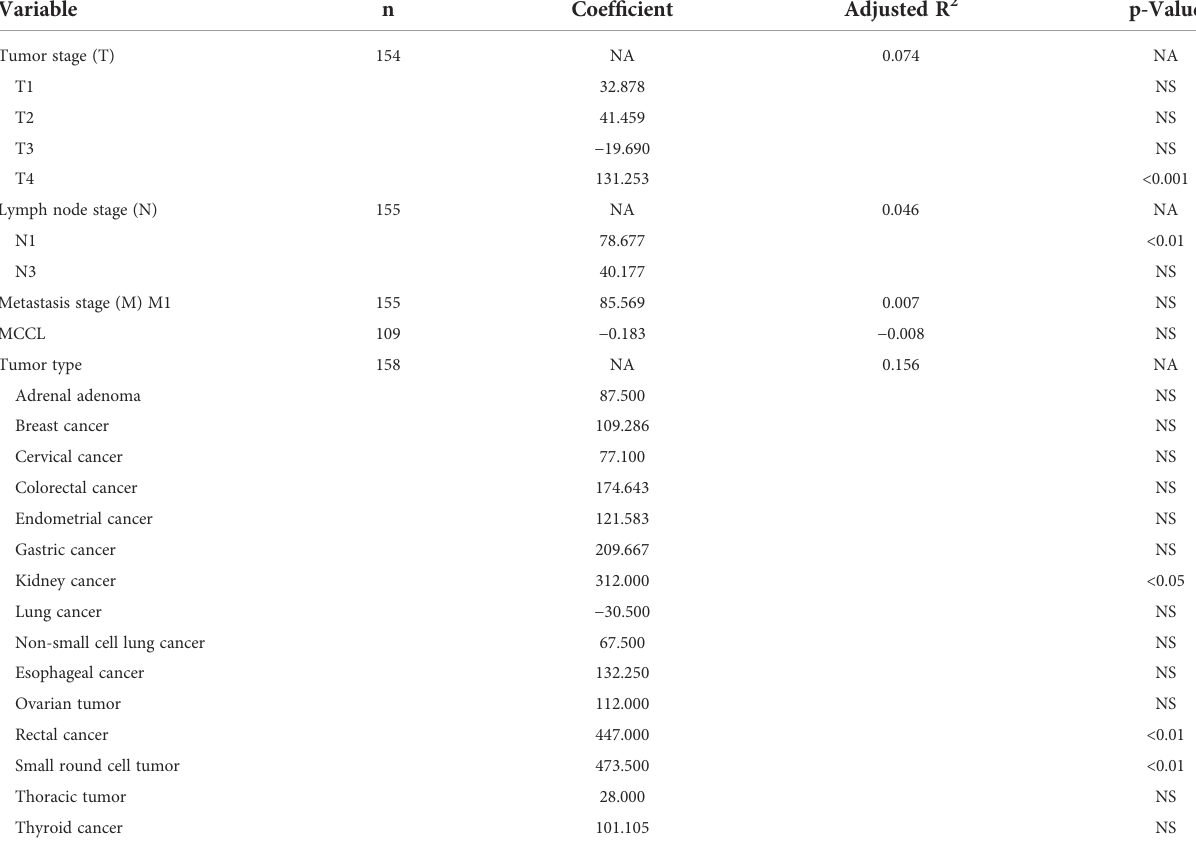
TABLE 4 Univariate analysis of correlation between tumor-related variables and LIT